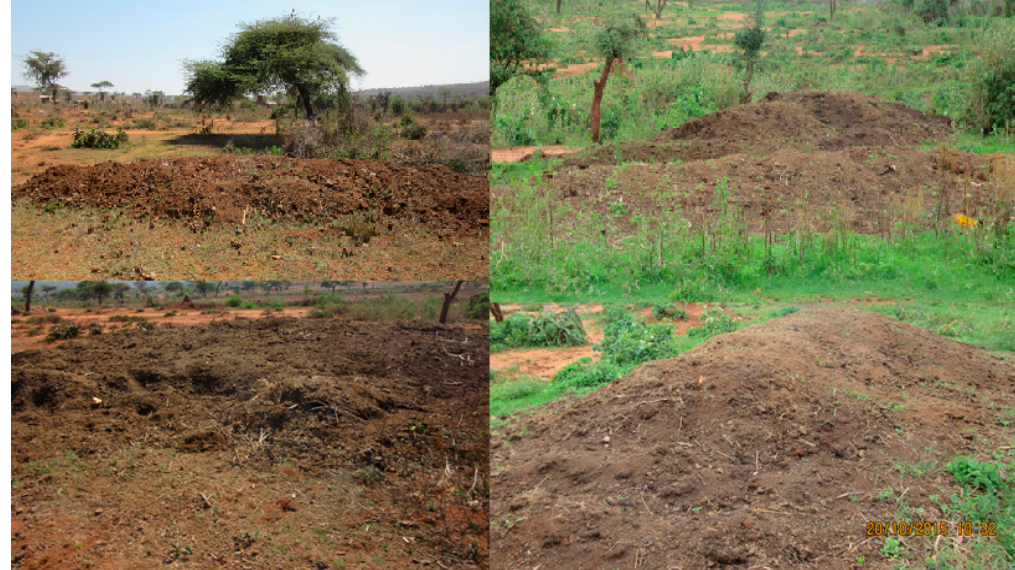
Figure 4. Representative pictures showing cattle manure heaps (dunghills) in Borana, southern Ethiopia. Photograph by the first author.